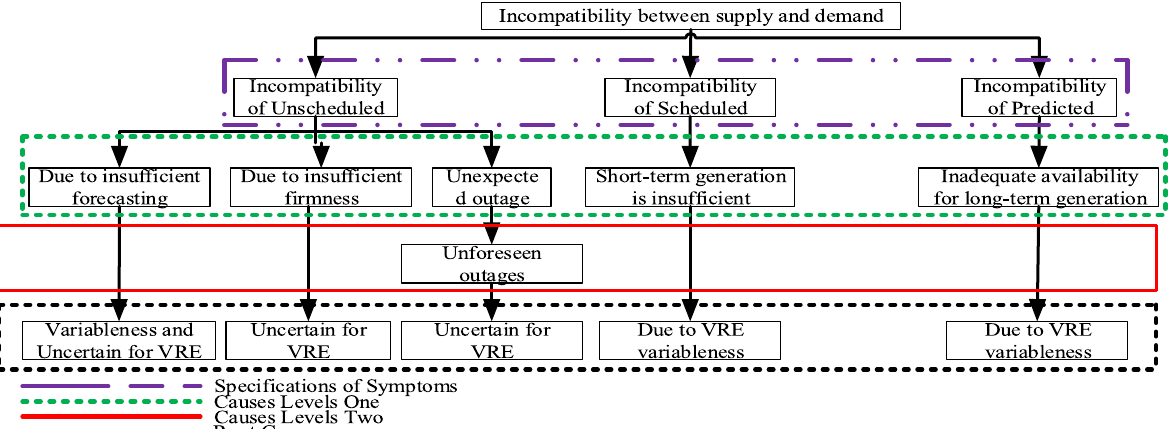
Fig. 1 Analysing the root cause to balance